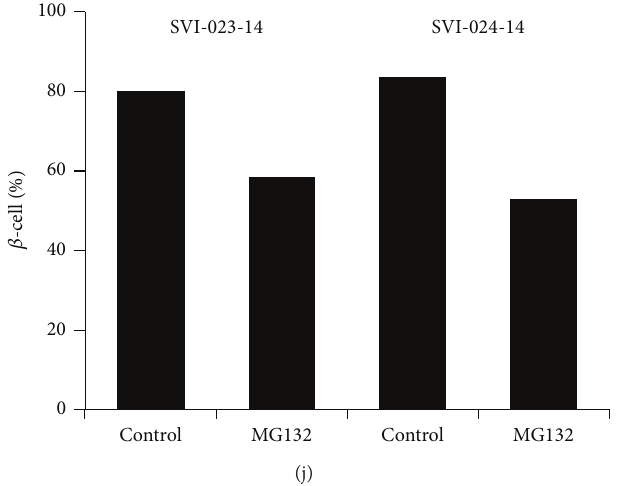
Figure 2: Palmitate and MG132 treatment induces a similar increase in levels of ubiquitinated proteins in pancreatic islets and 𝛽 -cells. ((a)–(c)) ExpressionofubiquitinatedproteinsmeasuredbyWesternblotinhumanislets(a),mouseislets(b),orMIN6cells(c)undercontrolconditions or following 0.5mM palmitate treatment as indicated. Band intensities were quantified, with values of the specific time points standardised to 𝛽 -actin loading control levels. Results represent fold induction levels, relative to control. ((d)-(e)) MIN6 cells were treated with 0.5 mM palmitate (d) and 10 𝜇 M MG132 (e) for 0 (untreated), 2, 4, and 8 h. Proteasome activity was measured using the Proteasome 20S Activity Assay kit. Results represent fold induction levels relative to the control. (f) MIN6 cells were treated with 10 𝜇 M MG132 as indicated and levels of ubiquitinated proteins were measured by Western blot analysis. ((g)-(h)) MIN6 cells were treated with 0.5 mM palmitate (g) and 10 𝜇 M MG132 (h) for 24 h and cell death was visualised by HO/PI staining. White arrows indicate cell death. (i) Western blot for cleaved caspase-3 in MIN6 cells after treatment with MG132 as indicated. (j) Human islets isolated from organ donors were treated for 24h with MG132 and % of 𝛽 -cells detected by Newport green staining and flow cytometry. Results are the means ± SEM of 3-4 independent experiments, except for Figures 2(a), 2(b), 2(i), and 2(j) (data representative of 2 independent experiments). ∗ 𝑃 < 0.05 ; ∗∗ 𝑃 < 0.01